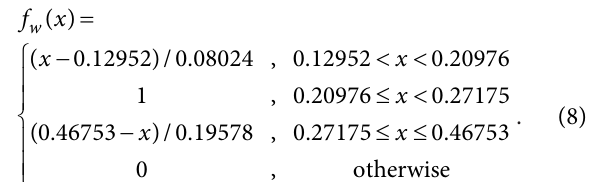
Figure 9. Fuzzy numbers of the five linguistic